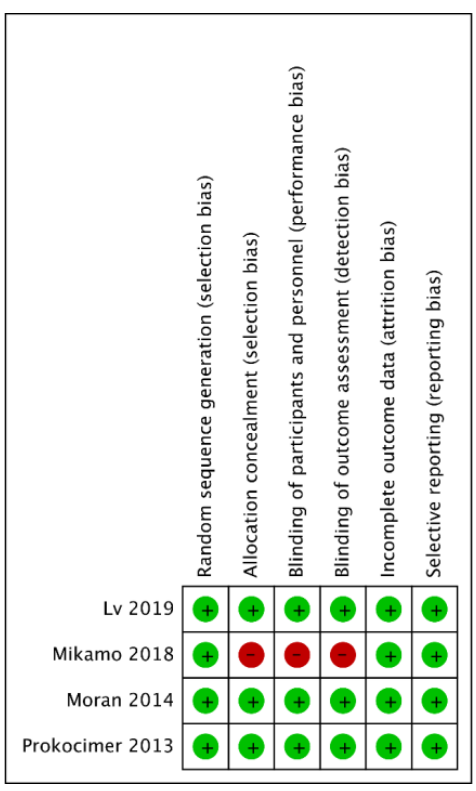
Figure 1. The algorithm of study selection.